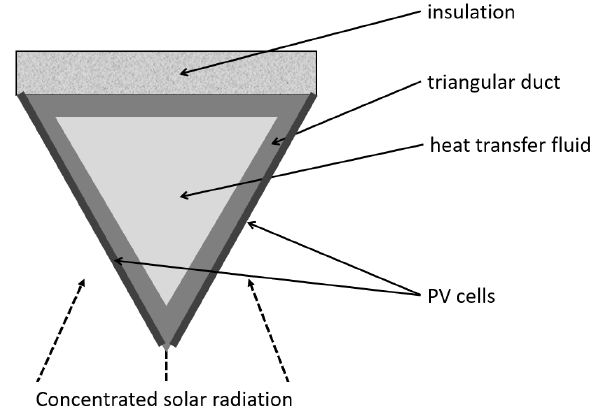
Figure 12. The cross-sectional view of typical triangular-duct heat receiver.